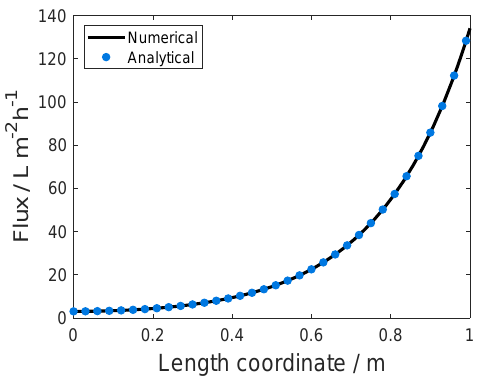
Figure 2. Validation of numerical method by comparison of numerical and analytical solutions of flux profile J ( x ) , shown for reference case.